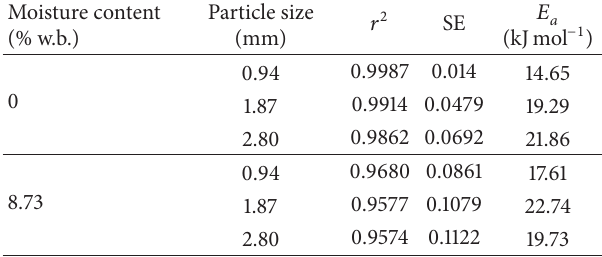
Table 3: Coefficients of determination ( 𝑟 2 ), mean standard errors (SE), and activation energy ( 𝐸 𝑎 ) for the oil extraction process from Jatropha seeds with different moisture contents and particle